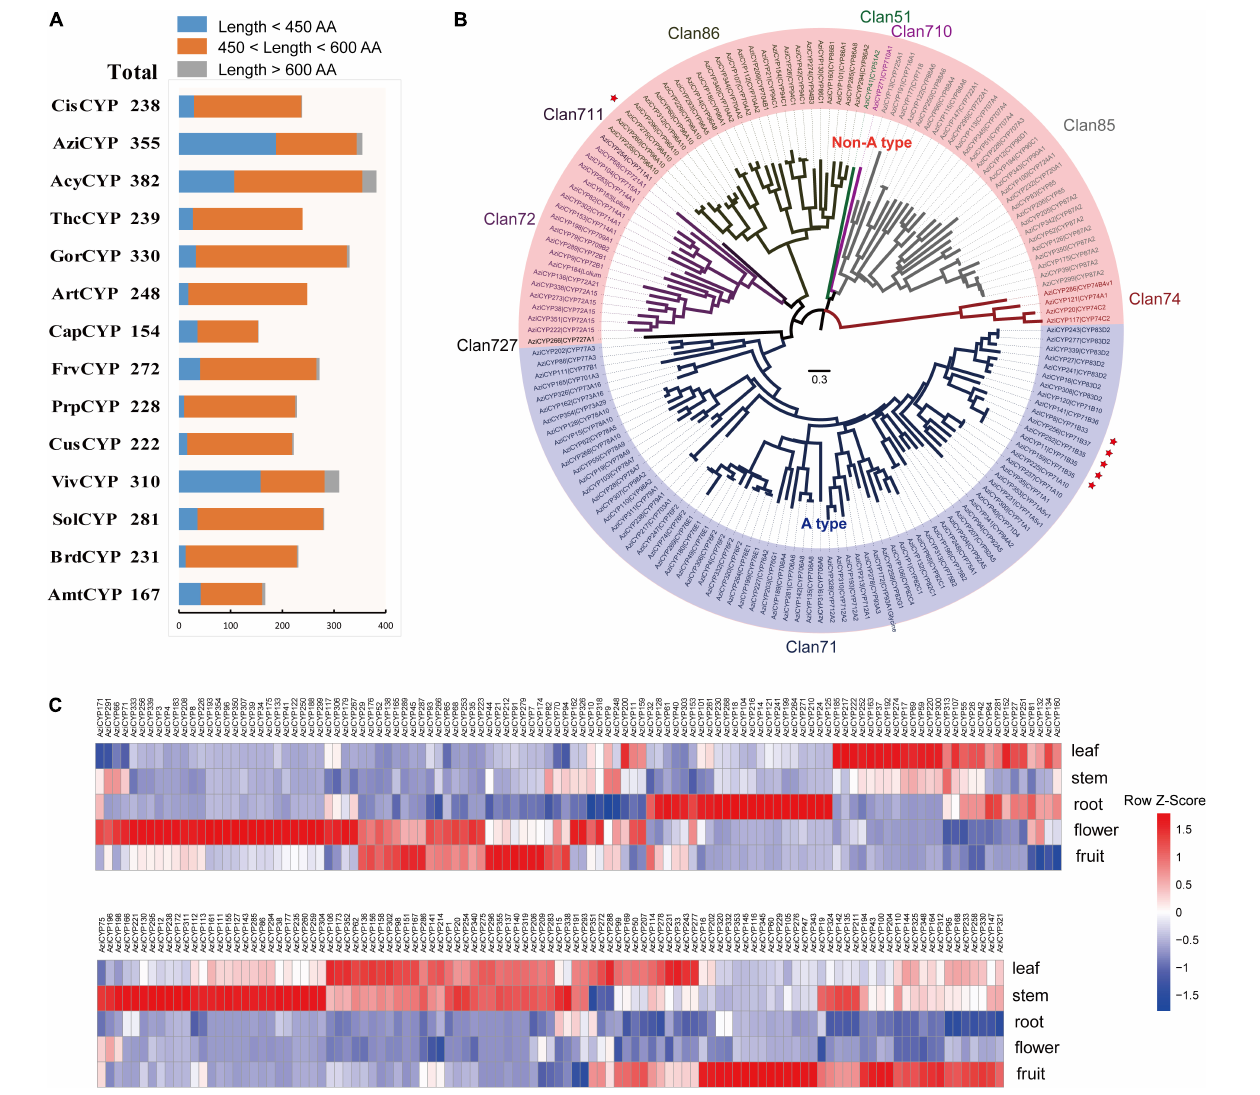
FIGURE 6 | Analysis of cytochrome P450 gene family in A. indica . (A) Statistics of predicted cytochrome P450 genes in A. indica and other 13 plants. (B) Phylogenetic analysis cytochrome P450 family members in A. indica based on the protein sequences. A ML tree was generated from an alignment of 156 A. indica cytochrome P450 protein sequences (450 < length < 600). The entire family of cytochrome P450 genes is shown for each clan next to the tree with different color. The A. indica P450 genes are highlighted by red stars. (C) A. indica CYP genes substantially expressed in five tested organs (fruit, flower, root, stem, and